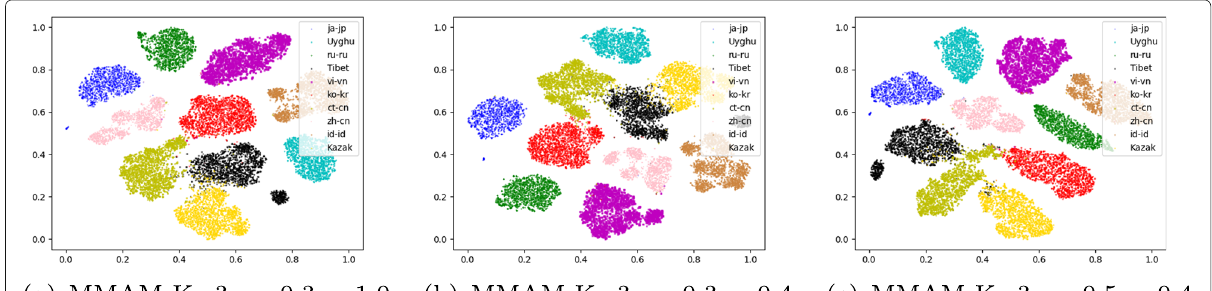
Fig. 11 Language embeddings of our proposed method are plotted by t-SNE, under test-all on AP17-OLR. Each shape/color represents a different language. a EER=1.44, C avg =1.31, min DCF=1.36. b EER=1.39, C avg =1.39, min DCF=1.41. c EER=1.35, C avg =1.23, min